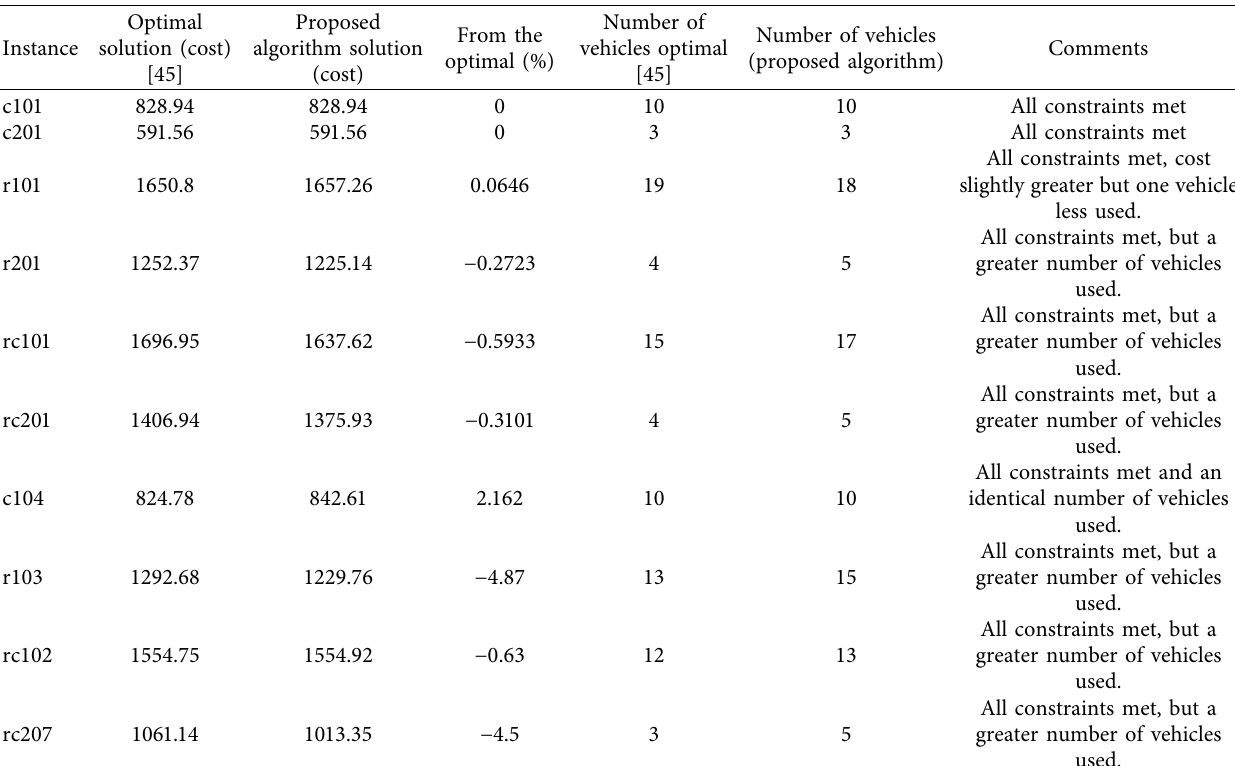
Figure 3: Proposed regression model for one parameter. Table 1: Testing results for Solomons’